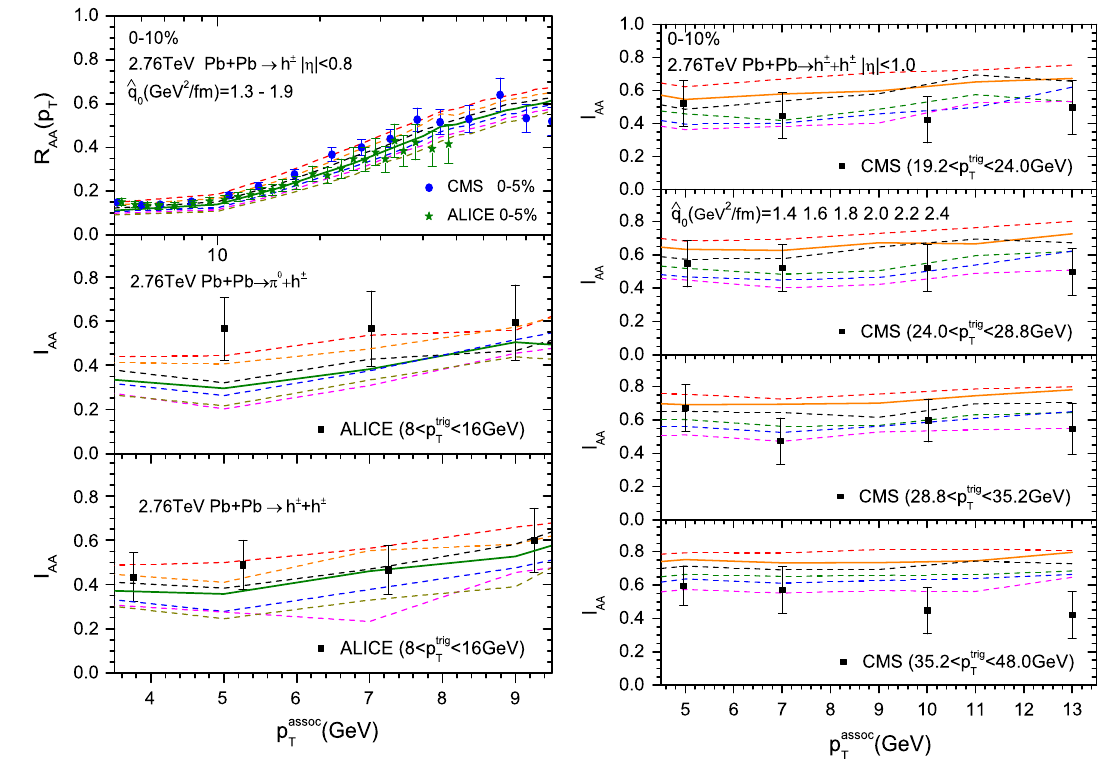
√ s NN = 2 . 76 TeV compared with CMS [38,45] and